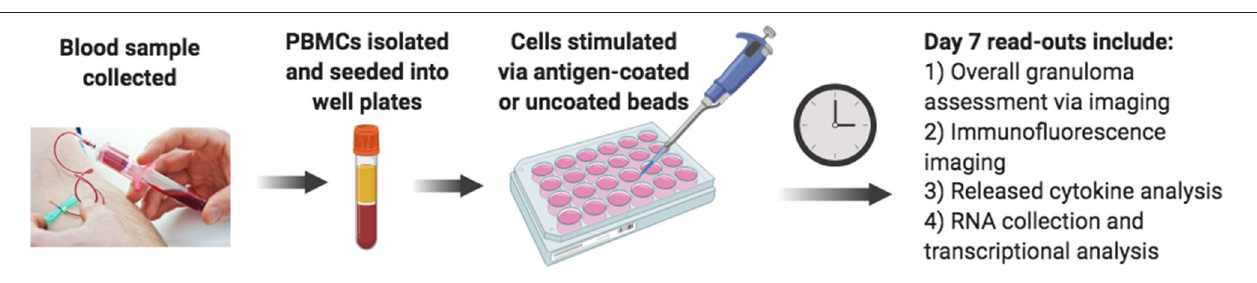
FIGURE 2 | Schematic diagram of the in vitro human granuloma